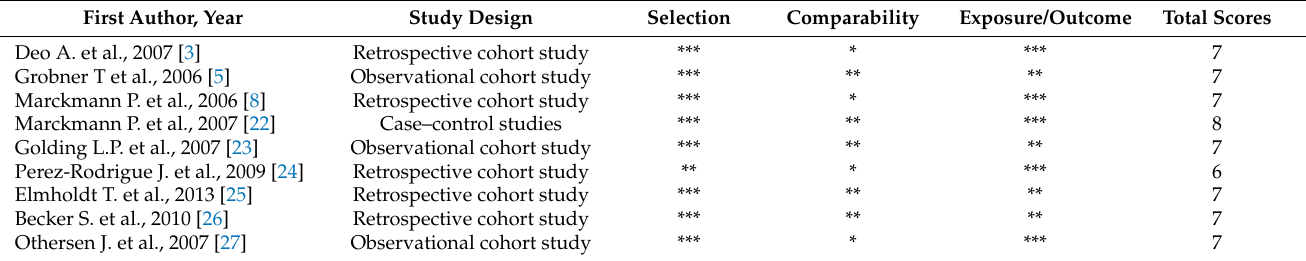
Table 3. Quality assessment of the included studies by the Newcastle–Ottawa